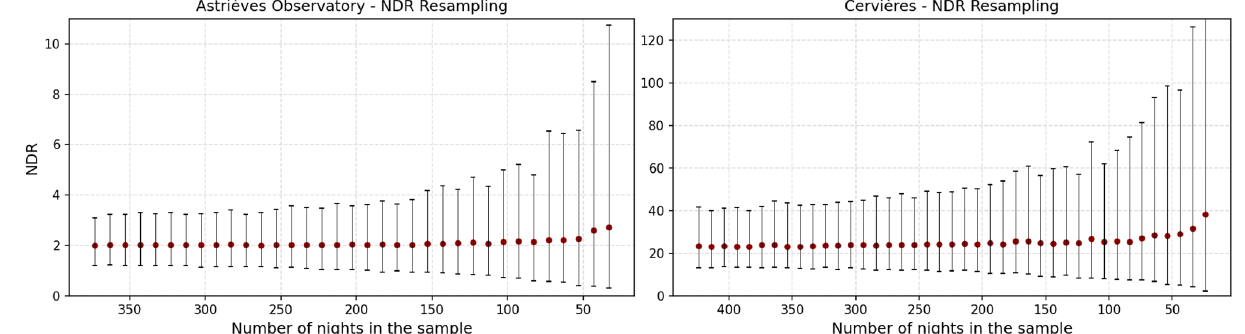
Figure 12. Results of the NDR resampling on the two data sets of Cervières and Astrièves Observatory. The horizontal axis is the number of nights considered into the night sample and the vertical axis provides the NDR indicator obtained for each sampling set through a 1000-iteration bootstrapping with replacement